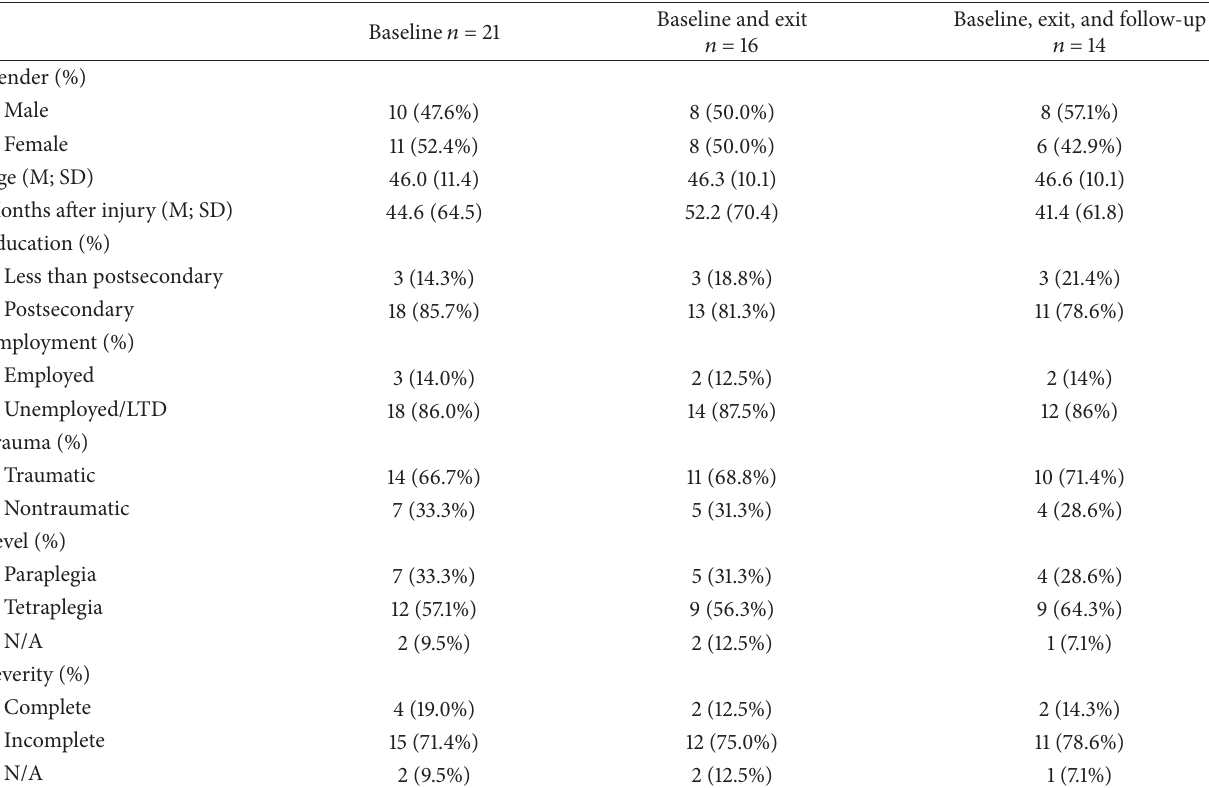
Table 1: Sample characteristics.